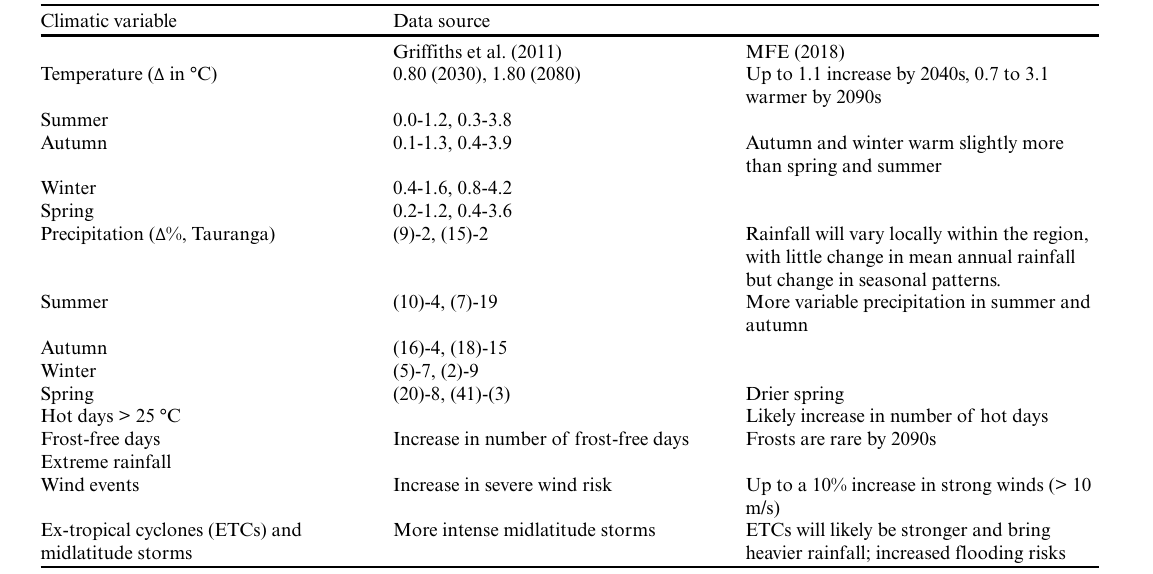
Table 5 . Climate change projections for the Bay of